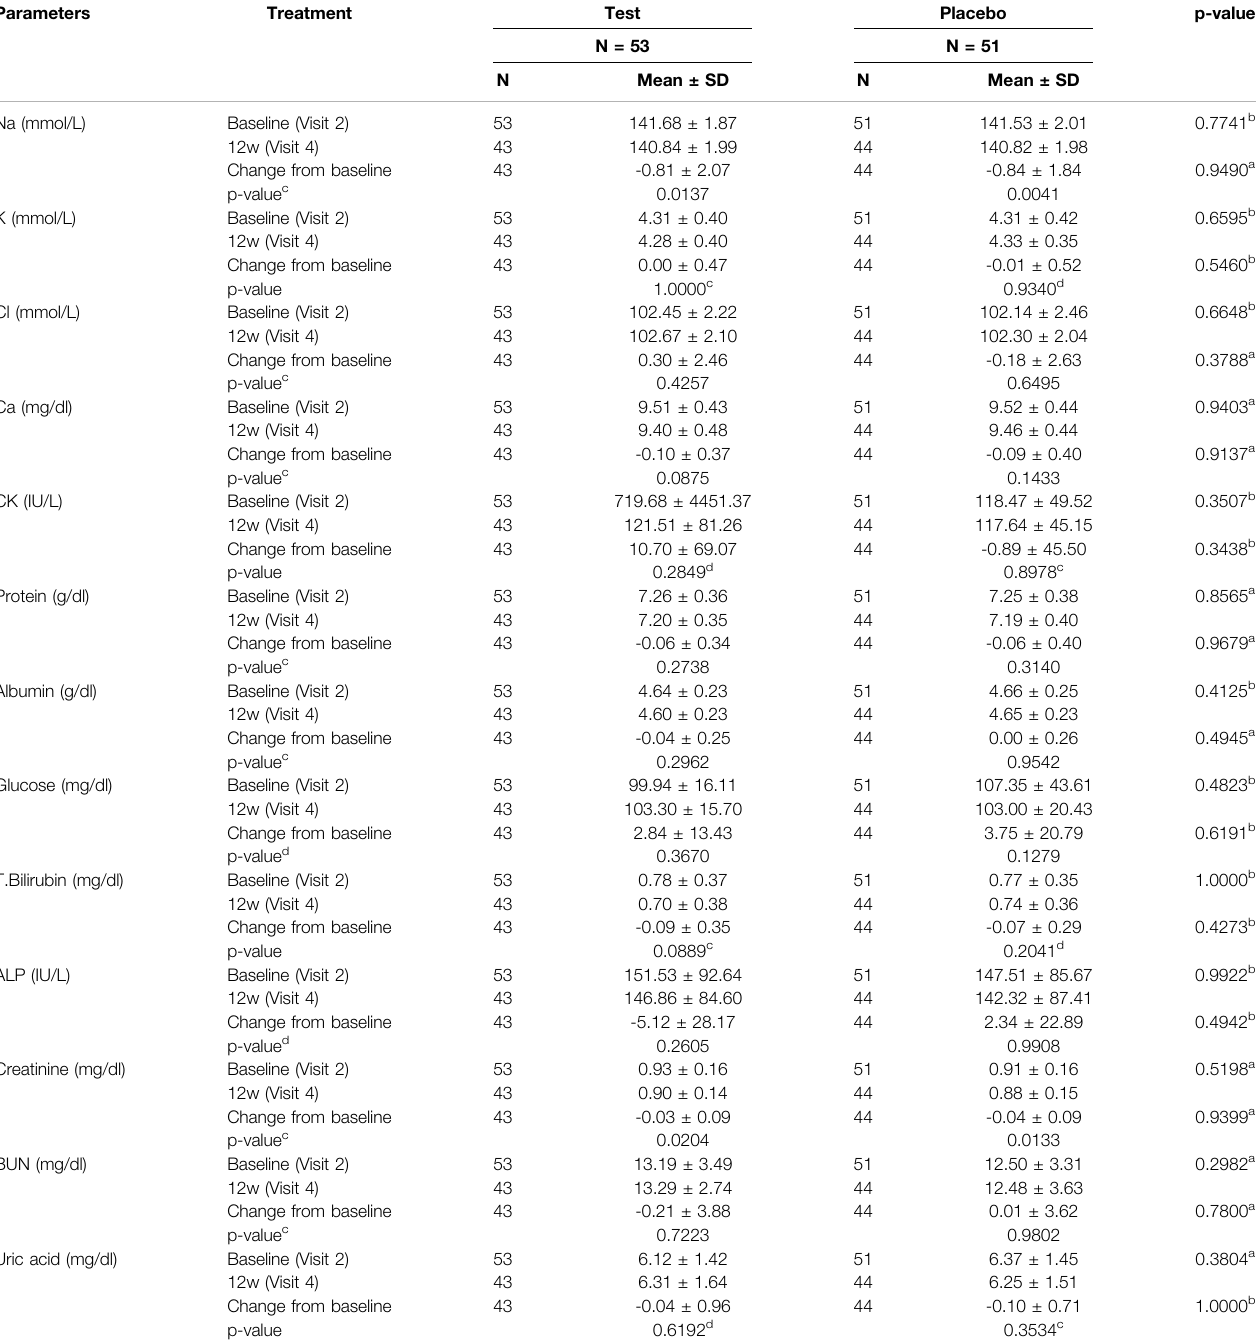
TABLE 10 | The association between the blood chemistry parameters and Golden- Antrodia Camphorata (Safety set). Parameters